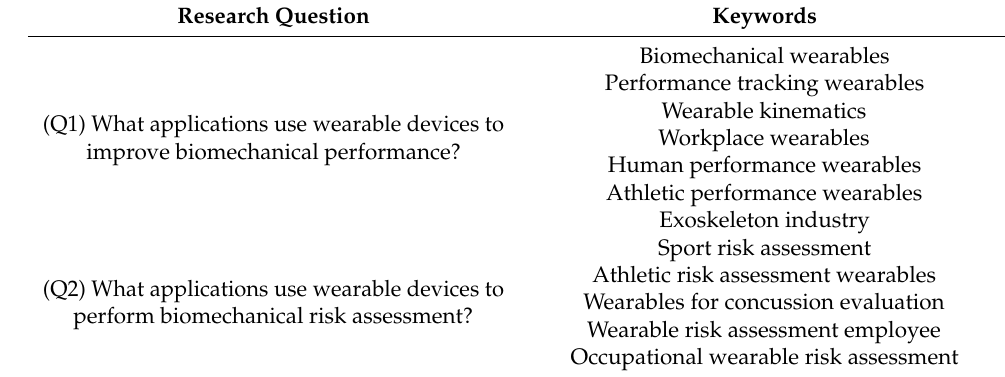
Table 1. Research questions and keyword search terms used in the academic research databases.